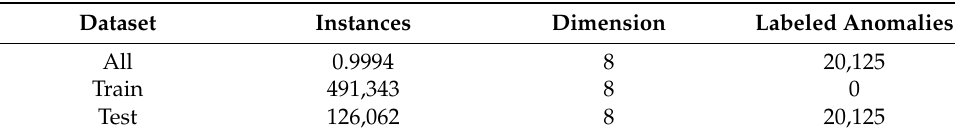
Table 1. Detailed dataset